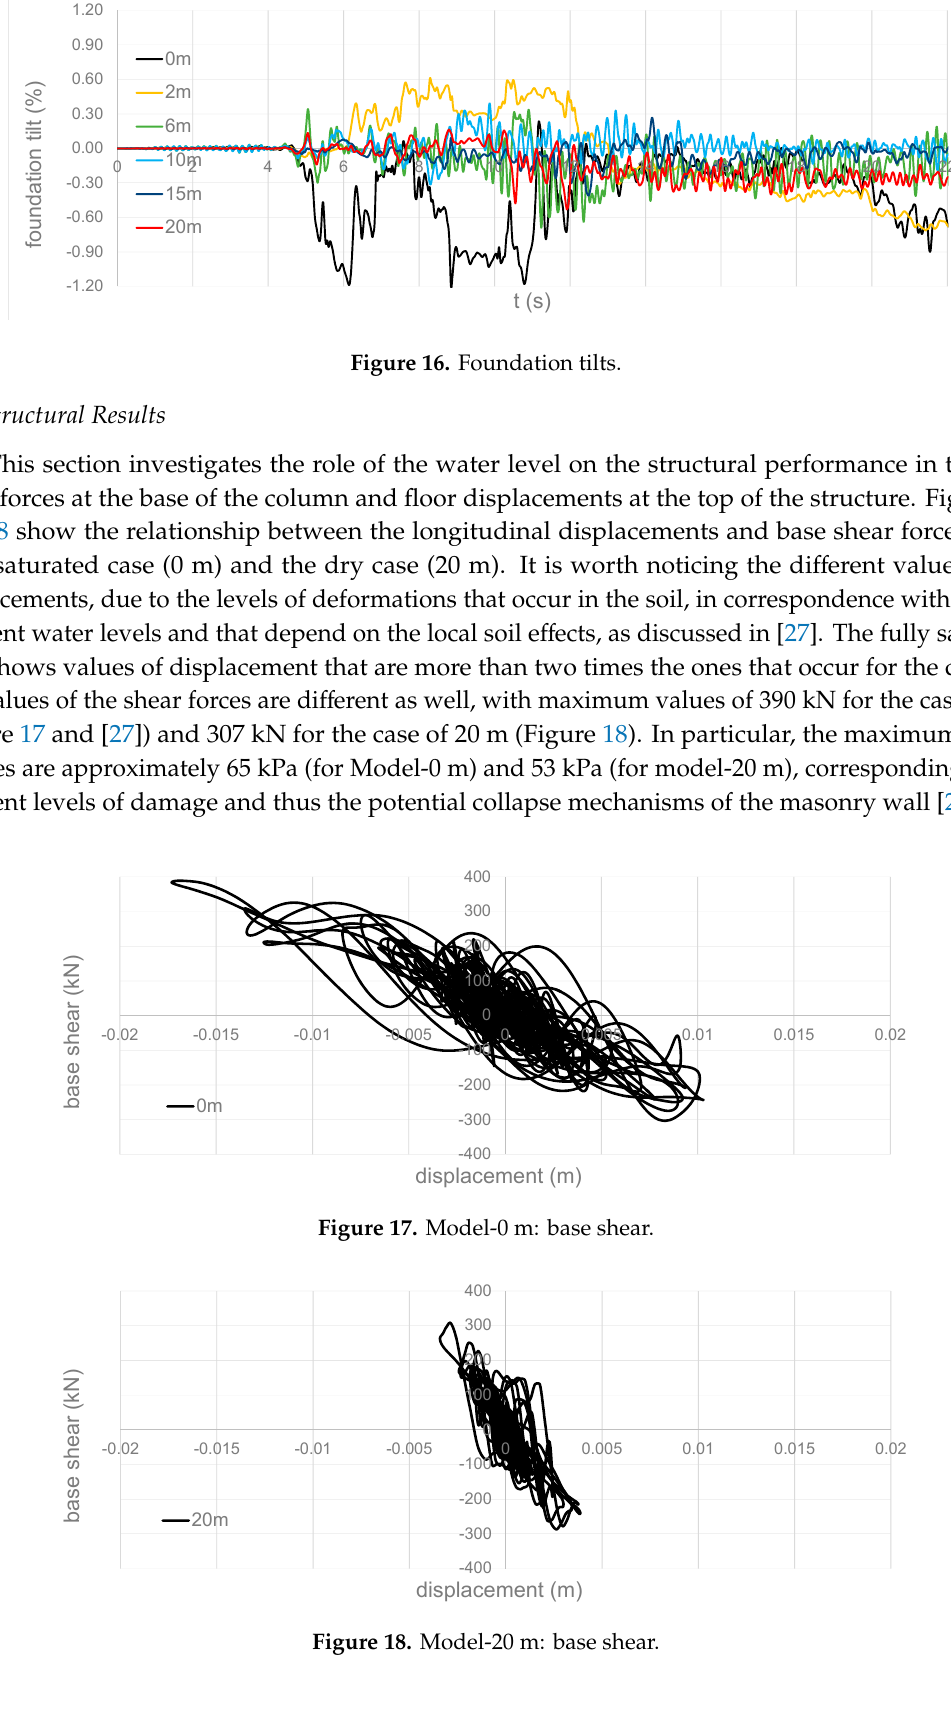
Figure 15. Foundation settlements.